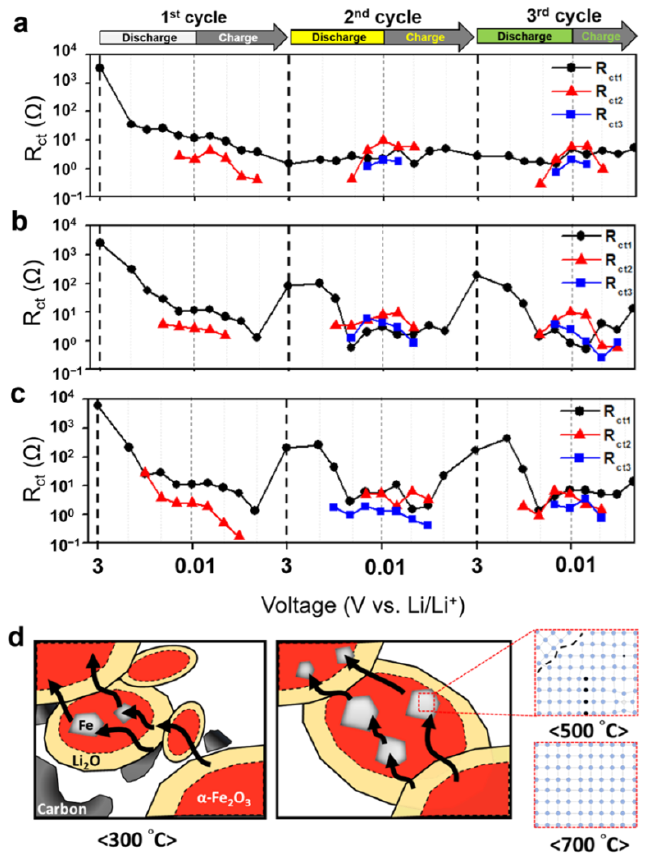
Figure 6. Calculated R ct1 , R ct2 , and R ct3 at each voltage by separation of charge transfer resistance of ( a ) FO300, ( b ) FO500, and ( c ) FO700; ( d ) schematic diagram of the electrical path in α -Fe 2 O 3 nano- fibers.